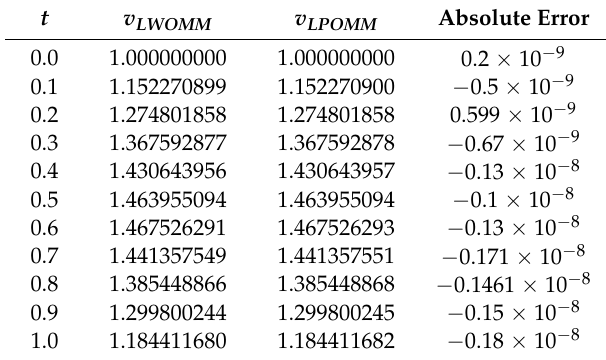
Table 2. Numerical solutions of v ( t ) when α = 0.9 attained by the introduced method and the LPOMM for Example 1.